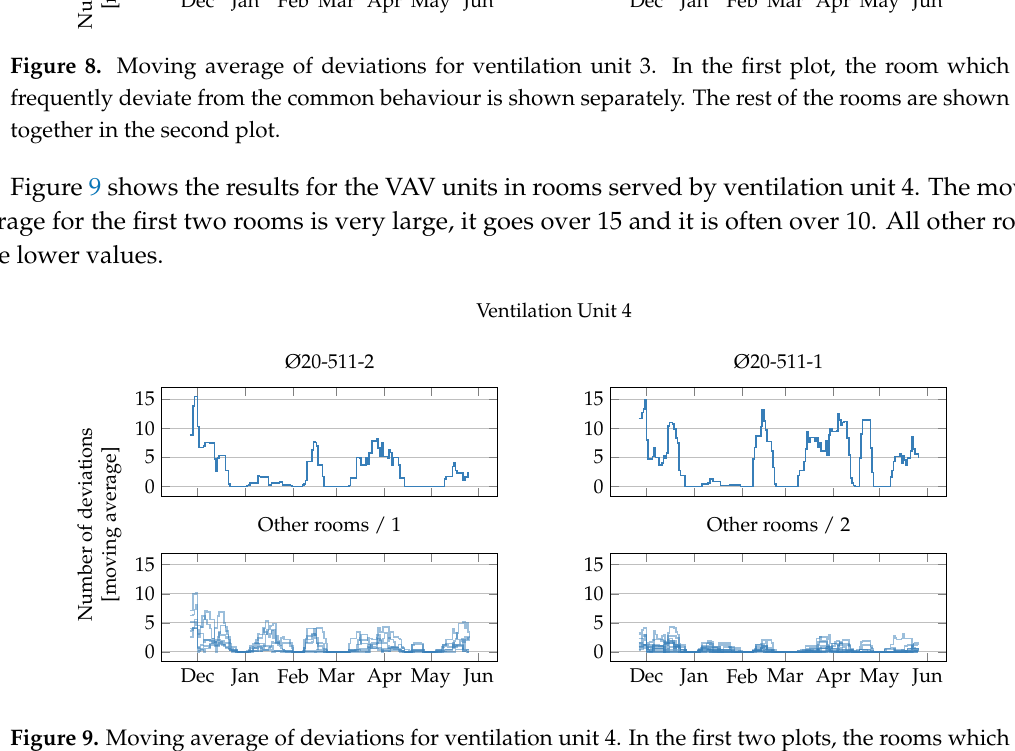
Figure 9. Moving average of deviations for ventilation unit 4. In the first two plots, the rooms which frequently deviate from the common behaviour are shown separately. The rest of the rooms are shown together in the last two